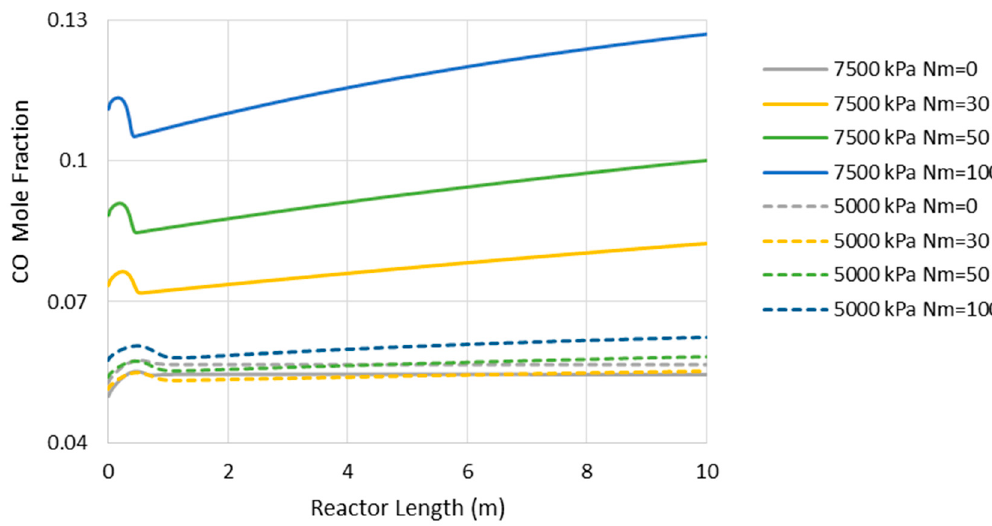
Figure 5. Carbon monoxide (CO) mole fraction through the adiabatic reactor’s length (Nm = 0 corresponds to CR).